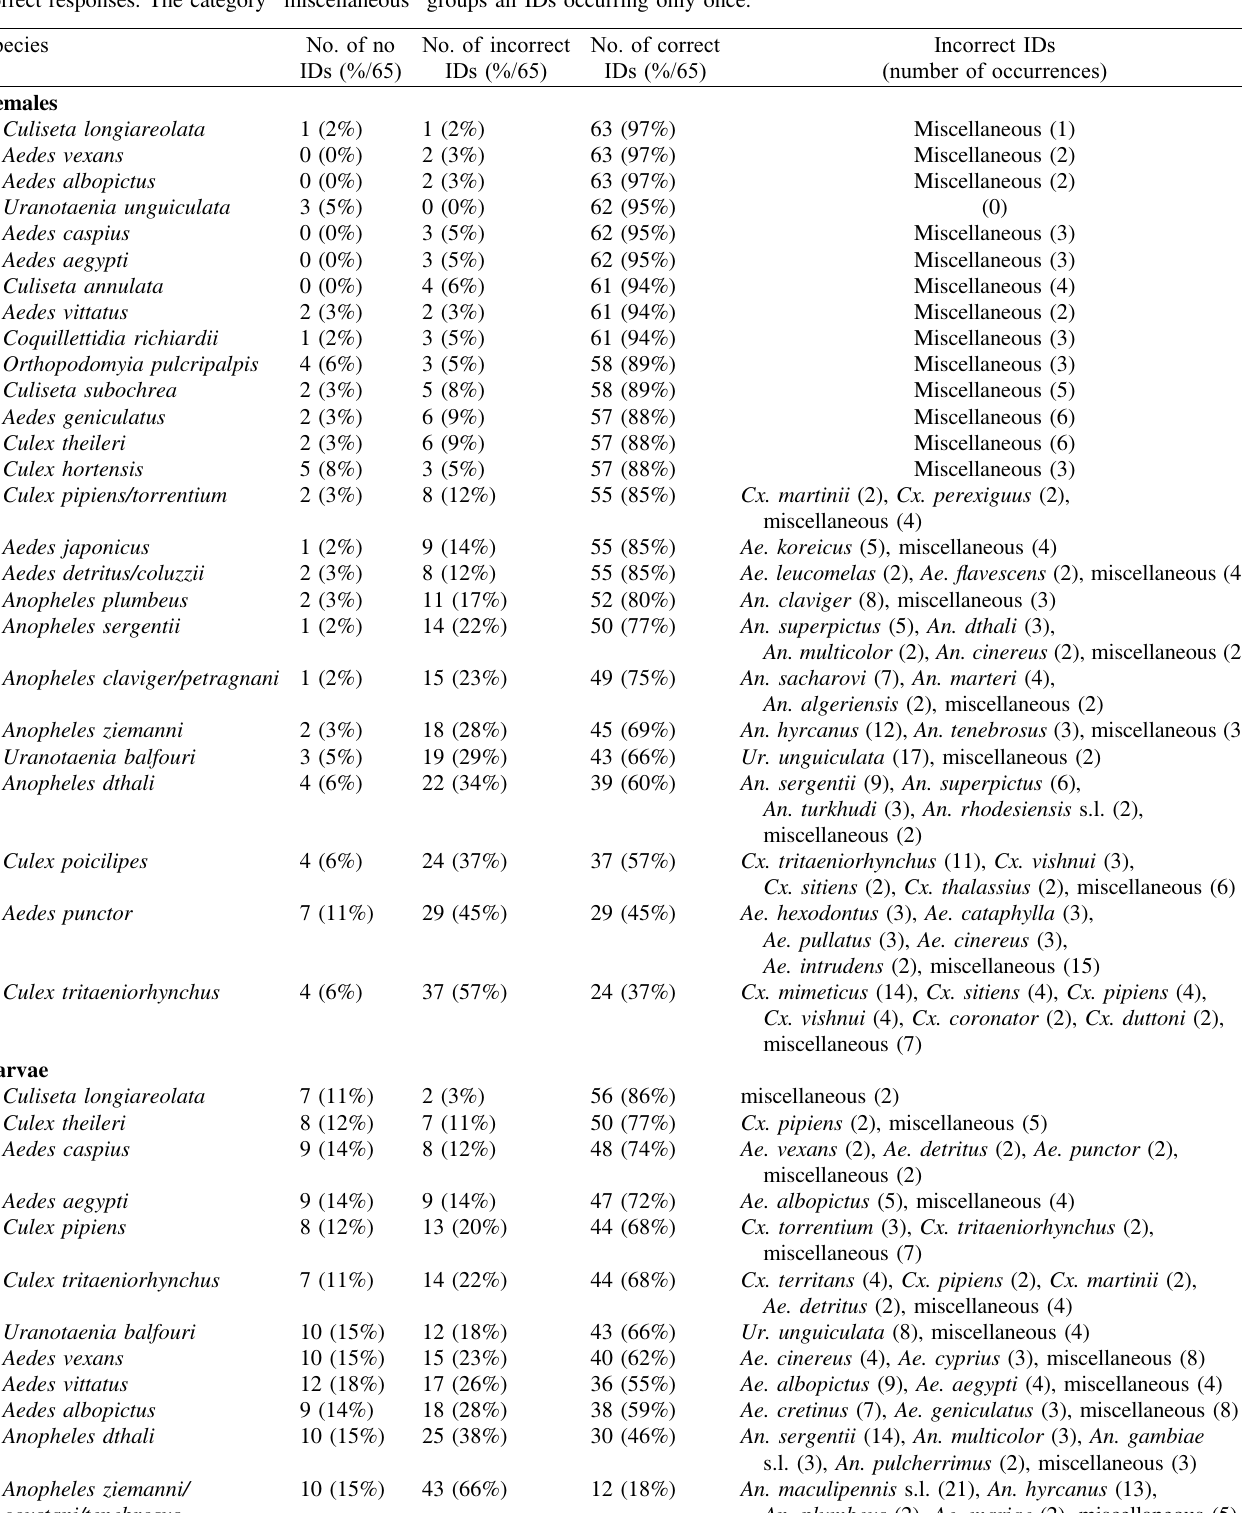
Table 2. Number of identi fi cations (No. of IDs) for 26 mosquito females and 12 larvae. Mosquito species are listed in decreasing percent correct responses. The category “ miscellaneous ” groups all IDs occurring only